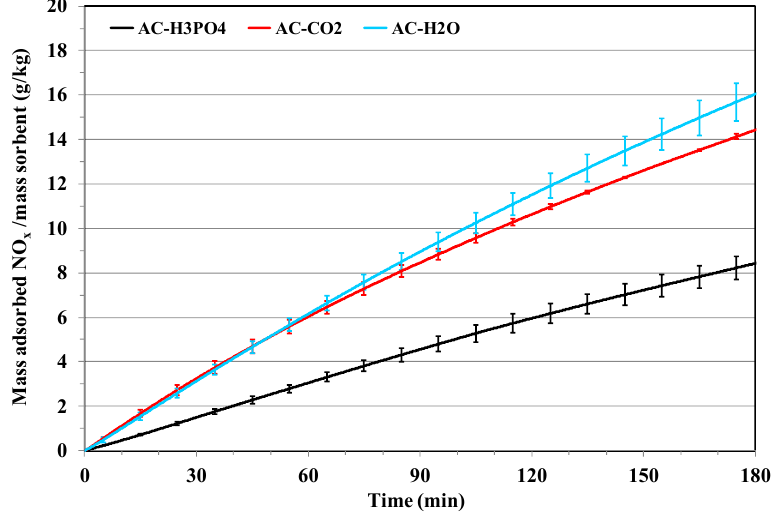
Figure 9. NO x capacities of three differently activated sorbent samples made from olive stones loaded for 3 h with NO 2 (5 ppm) at23 °C, c 1 NO = 0 ppm,50% RH with v = 0.2 m/s.